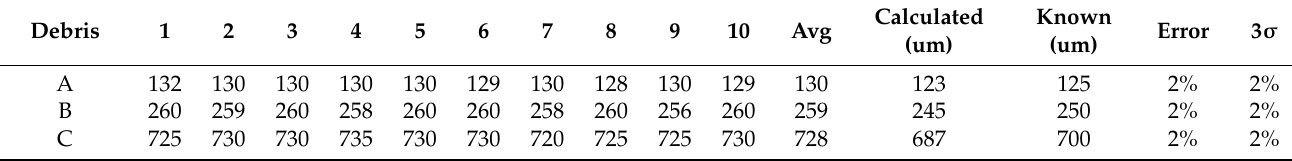
Figure 12. Images of the debris enlarged by the microscope indicate the known heights ( A ) 125 µ m, ( B ) 250 µ m, and ( C ) 700 µ m. Table 5. Measurements of the debris on the modulator.